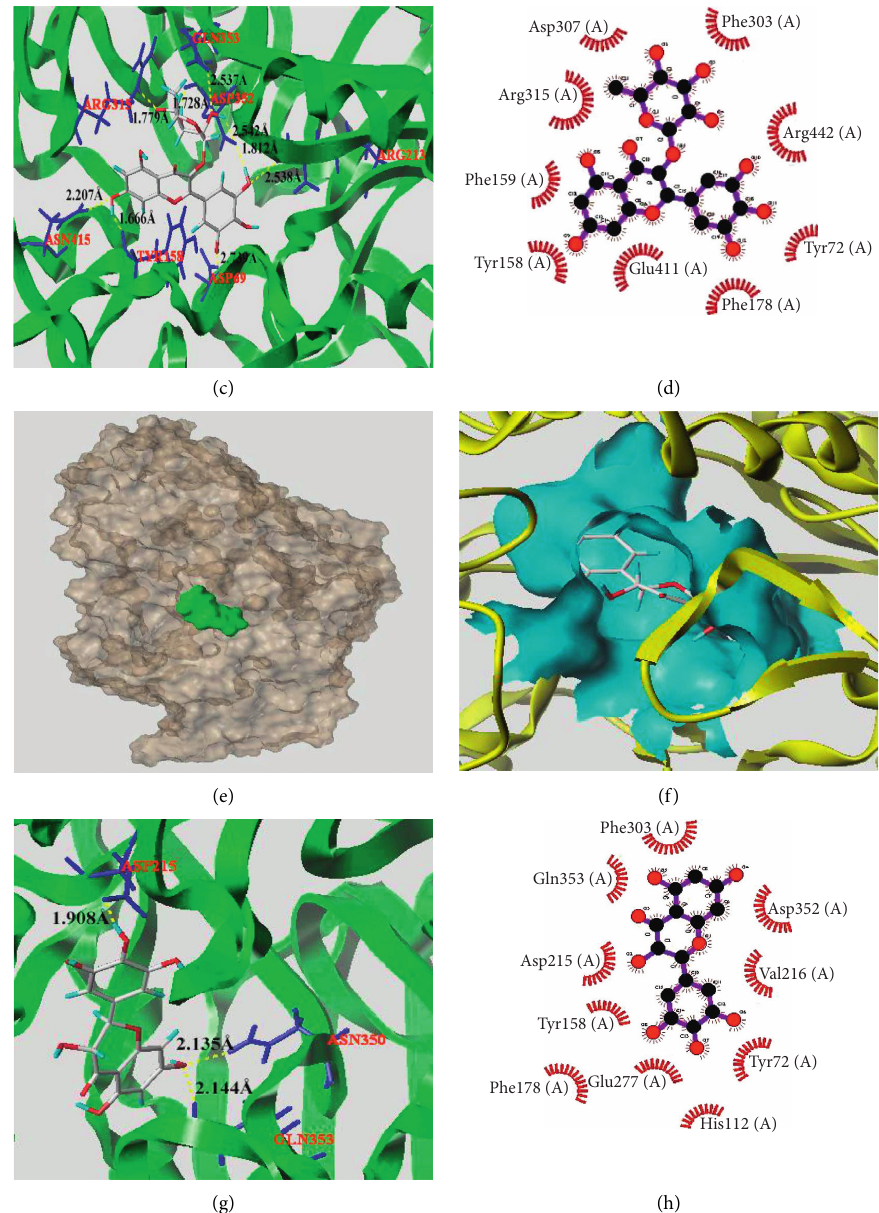
Figure 3: The molecule docking results of myricetrin (a–d) and dihydromyricetin (e–h) with α